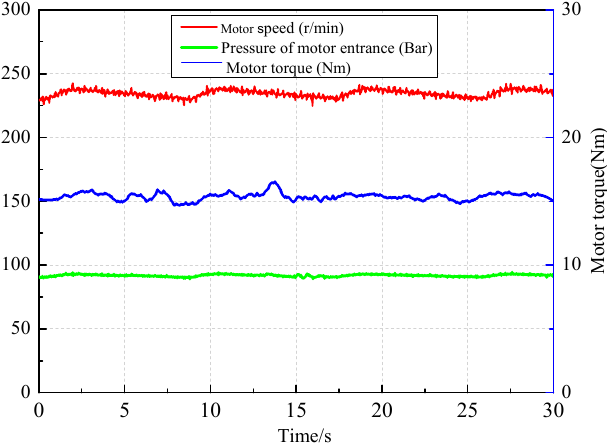
Figure 11. Motor torque, speed, and pressure curves.